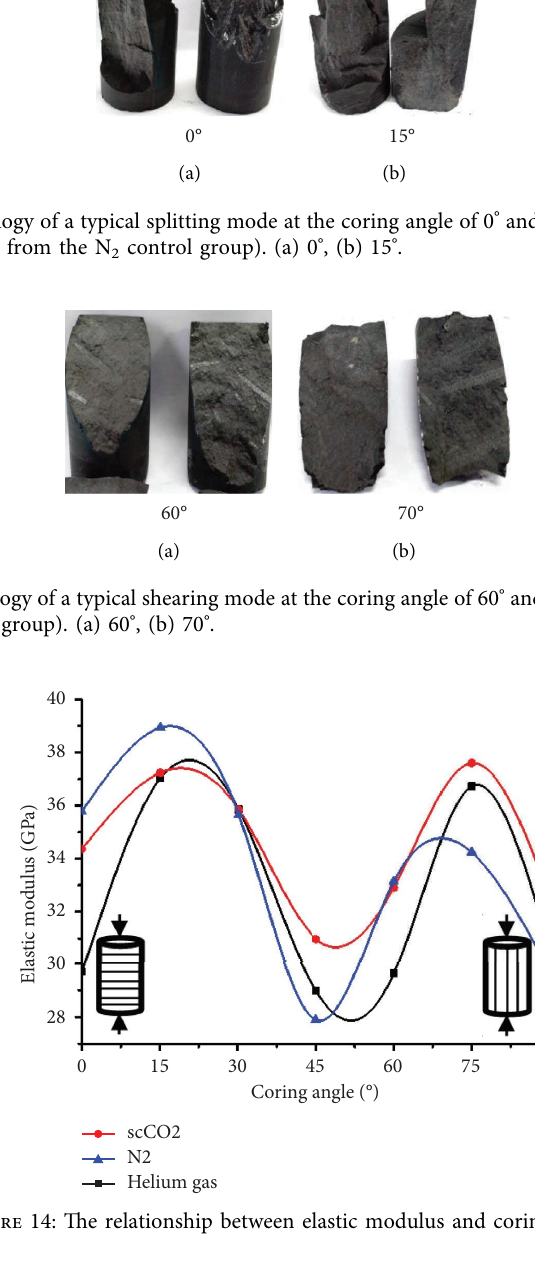
Figure 14: Te relationship between elastic modulus and coring